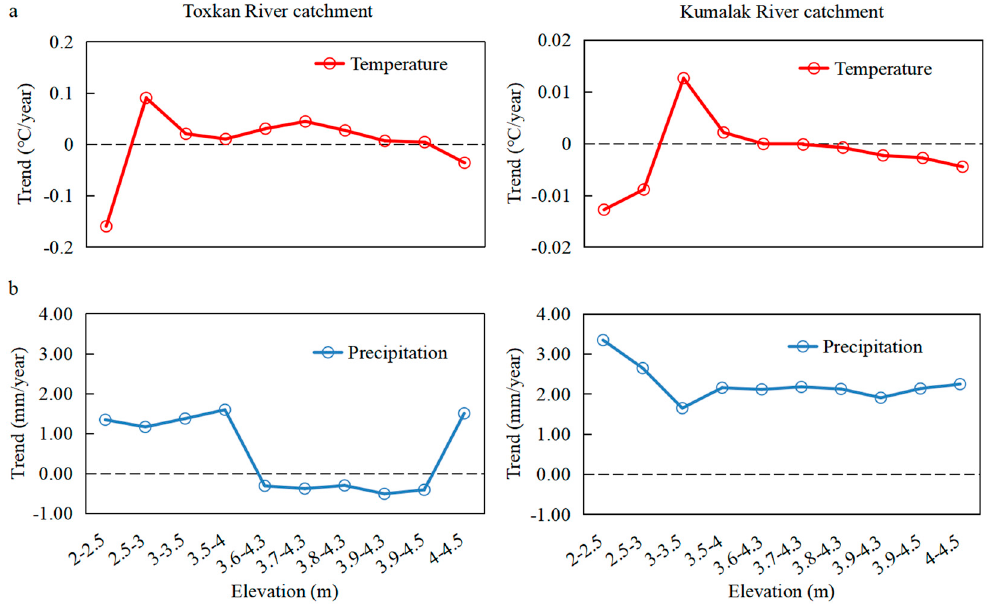
Figure 10. Change rates in summer temperature and precipitation during at di ff erent altitudes in the Toxkan and Kumalak River catchments from 2002 to 2015. ( a ) Change rates in summer temperature; ( b ) Change rates in summer